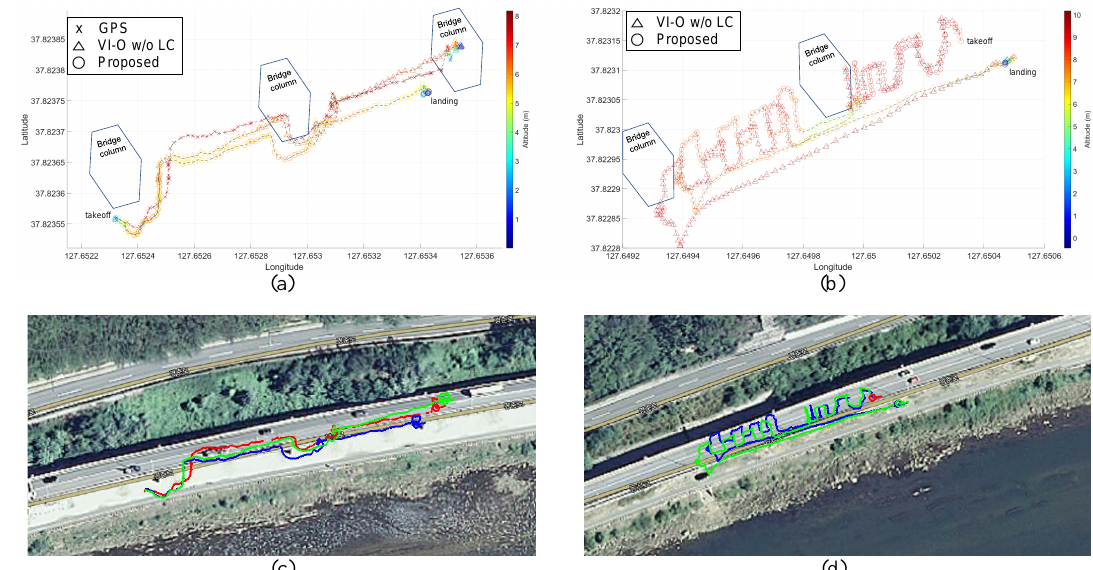
Figure 8. Trajectory estimation results. Note that the experiments were conducted under a bridge to compare the results of GPS positioning, VI odometry without loop closure (VI-O w/o LC), and the proposed SLAM method. ( a ) Estimation comparison for a straight trajectory. ( b ) Estimation comparison for a zigzag trajectory. ( c ) Plot of the straight trajectory results on the satellite map (red: GPS, green: VI-O w/o LC, blue: proposed). ( d ) Plot of the zigzag trajectory results on the satellite map (green: VI-O w/o LC, blue: